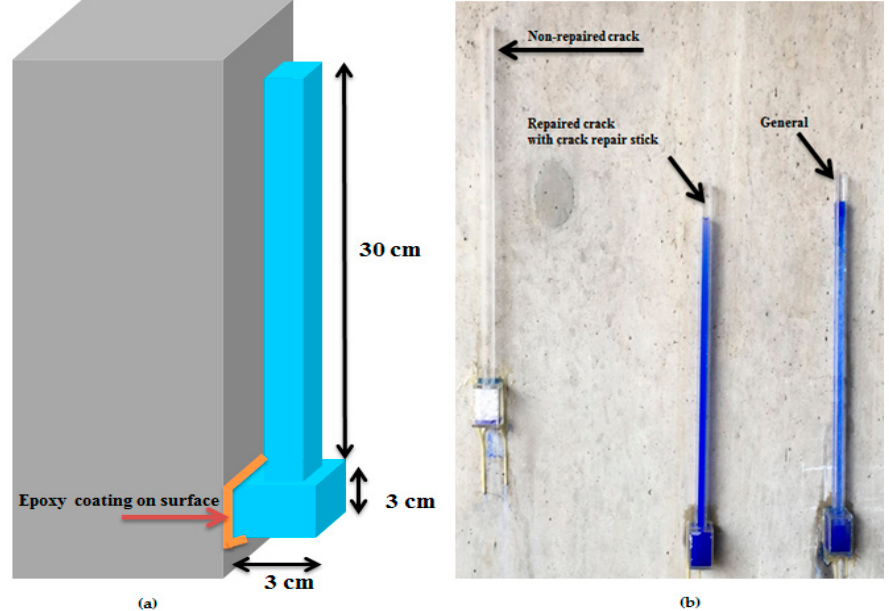
Figure 16 . ( a ) 3D diagram of tester installed on structure; ( b ) installed testers at the site.